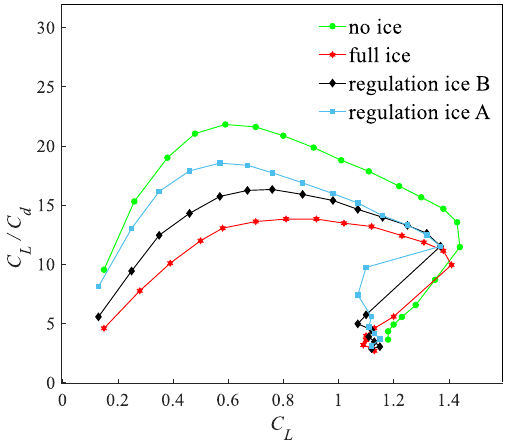
Figure 10. Lift-drag characteristic curves under four states.